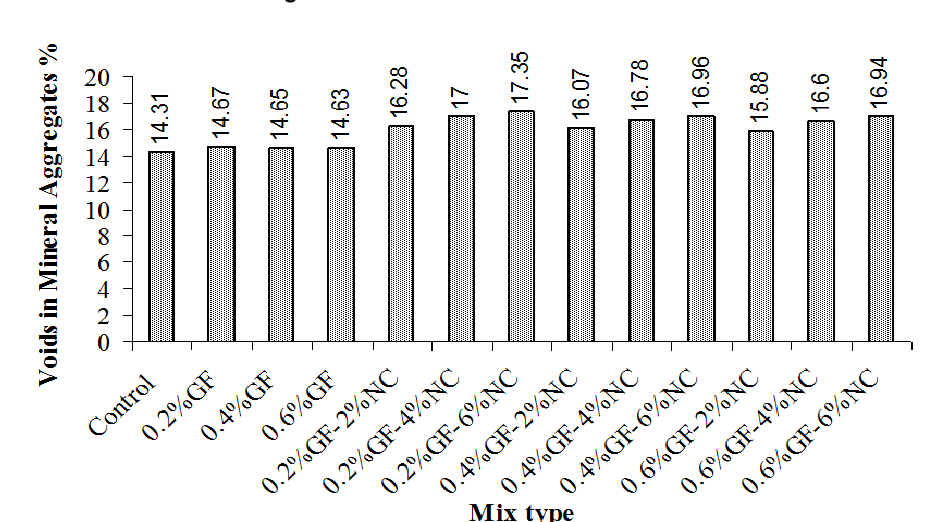
Fig. 6. Voids in mineral aggregates of the mixtures